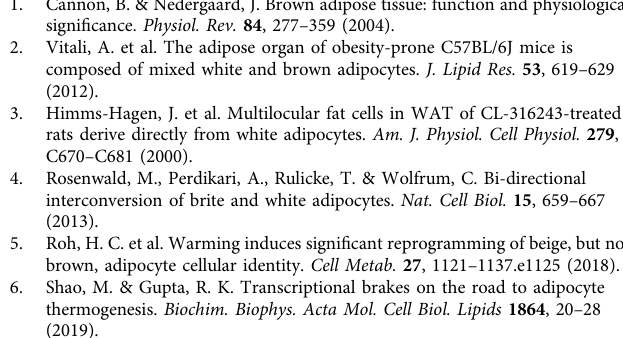
Supplementary Table 1. For miRNA extraction, Direct-zol ™ RNA MiniPrep (Zymo Research) was used. The miRNA was reverse-transcribed using the MicroRNA Reverse Transcription Kit (4366596, Thermo Fisher Scienti fi c) and TaqMan MicroRNA Assay (4440886, 4427975, Thermo Fisher Scienti fi c). RT-qPCRs were run using TaqMan Master Mix (RT600S, Enzynomics). The miR-3085-3p level was normalized to that of snoRNA202.